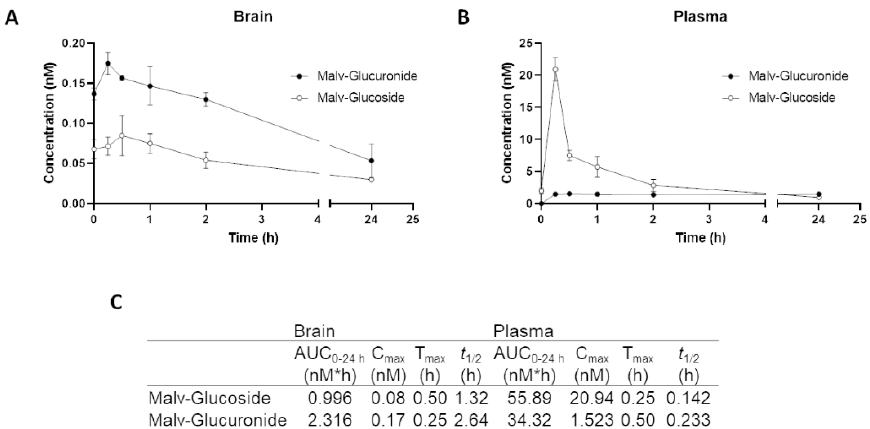
Figure 8. Pharmacokinetic study of malvidin glucoside administered by oral gavage daily at a concentration of 12.5 mg/kg for 7 days. MG levels in brain ( A ) and plasma ( B ) were measured after 30 min, 1, 2, 8, and 24 h after last administration ( n = 3 for each experimental group). Only the metabolites malvidin glucuronide and malvidin glucoside were detected. ( C ) Average pharmacokinetic parameters in brain and plasma following 7 days of MG treatment.